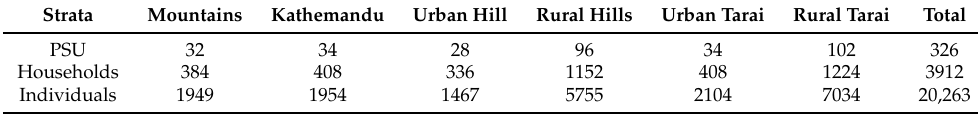
Table 1. Distribution of wards and households in the sample.